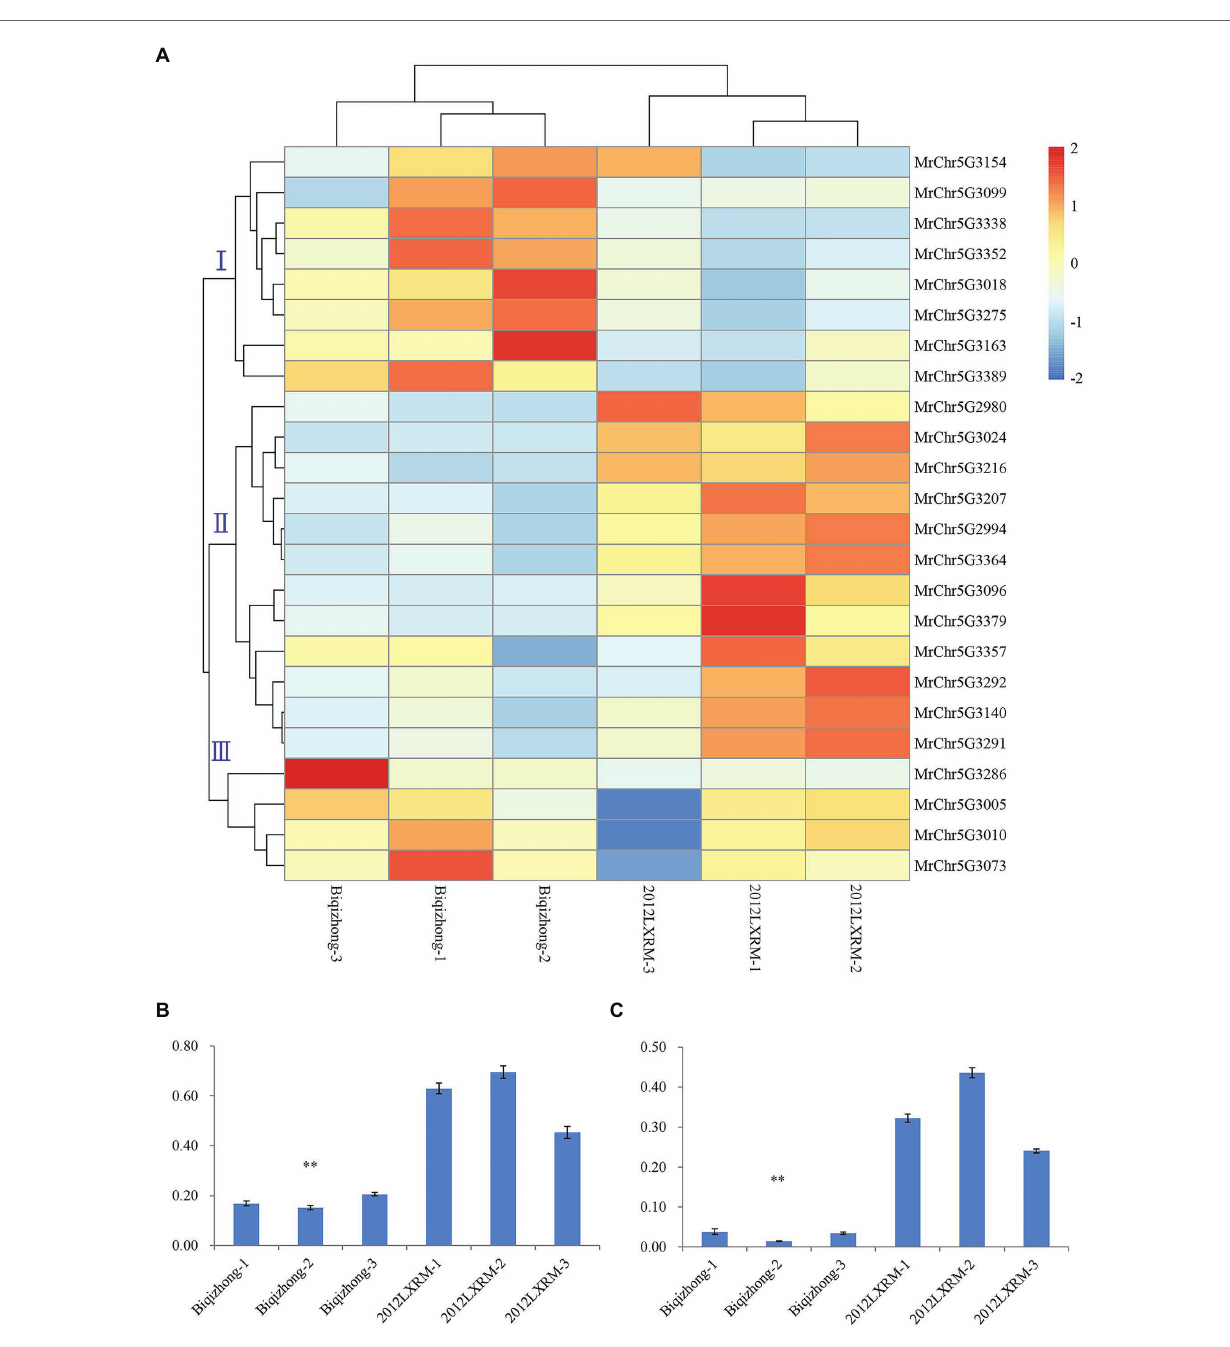
FIGURE 4 | The expression of 24 differentially expressed genes (A) . Relative expression of the candidate genes MrChr5G3291 (B) and MrChr5G3292 (C) in the LG5-cluster region. (A) Groups I, II, and III are three groups clustered according to gene sequence; blue and red represent downregulation and upregulation of gene expression, respectively; Biqizhong 1–3 and 2012LXRM 1–3 represent three replicate parental leaves. ∗∗ p =